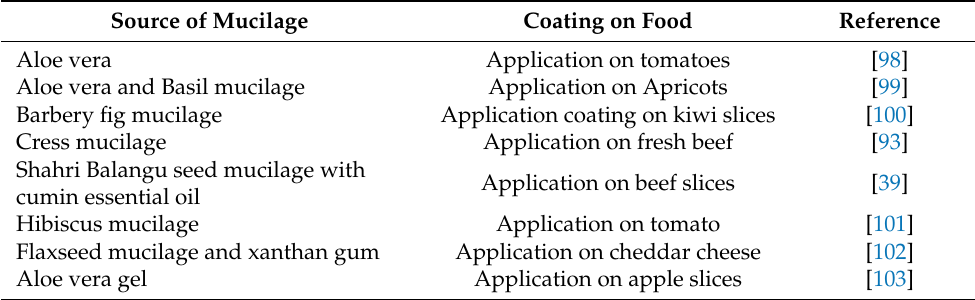
Table 4. Application of various plant-based Mucilage as a coating material in the food